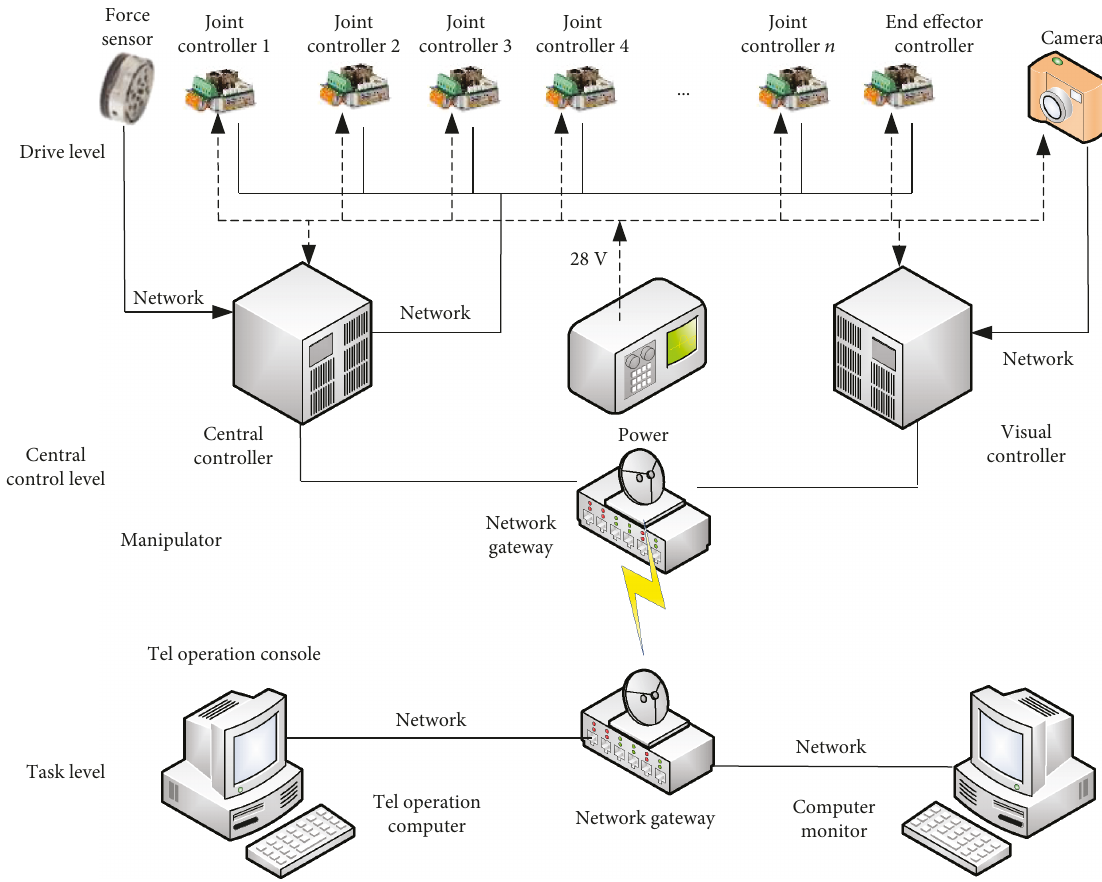
Figure 10: The distributed control system of the manipulator.